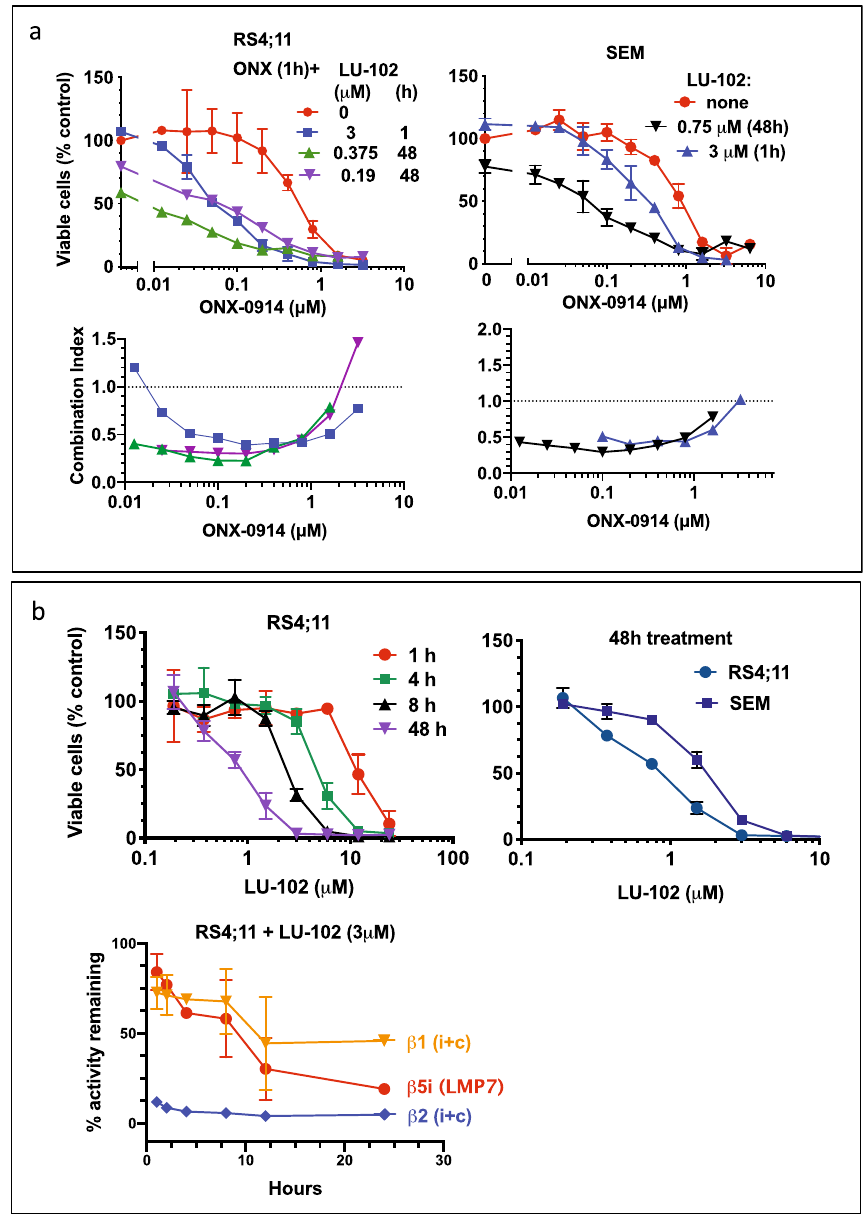
Figure 3. ß2 sites are co-targets for the treatment of ALL. ( a ) Cells were co-treated with ONX-0914 and LU-102 for 1 h, or treated with ONX-0914 for 1 h, followed by 47 h treatment with LU-102, and cell viability was assessed with Alamar Blue (top panels, n = 2–5). Combination indexes were calculated using CalcuSyn software (bottom panels). ( b ) Top panels, cells were treated with LU-102 for times indicated (left panel) or for 48 h (right panel). Cell viability was assessed with Alamar Blue 48 h after start of the treatments (n = 2). Bottom panel, inhibition of different active sites was measured with fluorogenic substrates in extracts of cells continuously treated with LU-102 (n =